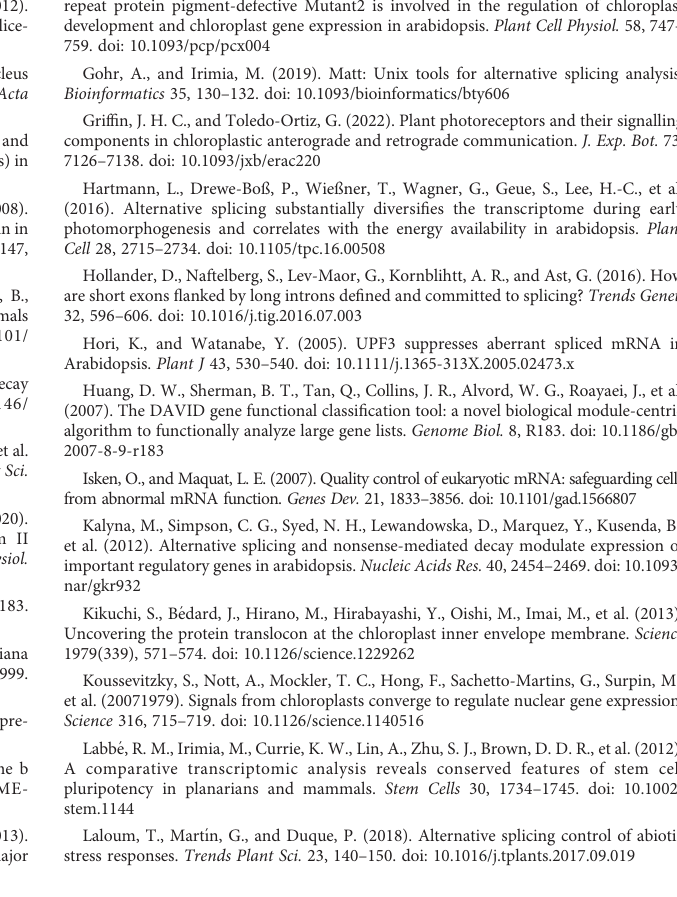
SUPPLEMENTARY TABLE 3 List of AS events differentially regulated by nor fl urazon in wild-type seedlings. Columns indicate information associated to each AS event including the locus, the vast-tools event identi fi er, the genomic coordinates, the length in pair bases, the type of event and the percent of inclusion (PSI) in 5-day-old wild- type (WT) and gun1 seedlings treated with nor fl urazon (NF) and untreated WTs. NA for PSI values indicates insuf fi cient read coverage (see Material and Methods for details). SUPPLEMENTARY TABLE 4 List of AS events differentially regulated by lincomycin in wild-type seedlings. Columns indicate information associated to each AS event including the locus, the vast-tools event identi fi er, the genomic coordinates, the length in pair bases, the type of event and the percent of inclusion (PSI) in 5-day-old wild- type (WT) seedlings treated or not with lincomycin (Linc). SUPPLEMENTARY TABLE 5 List of AS events differentially regulated by light in dark-grown wild-type seedlings. Columns indicate information associated to each AS event including the locus, the vast-tools event identi fi er, the genomic coordinates, the length in pair bases, the type of event and the percent of inclusion (PSI) in wild-type (WT) seedlings grown in continuous darkness (D) or white light (WL) for 3